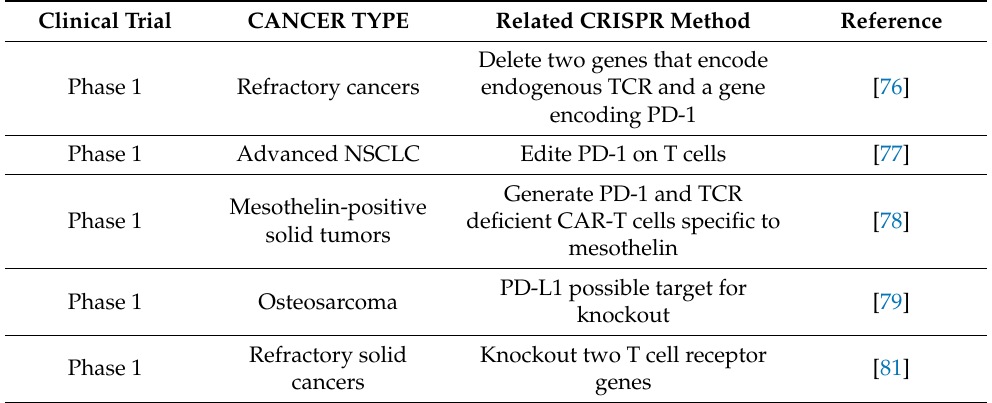
Table 3. Current clinical